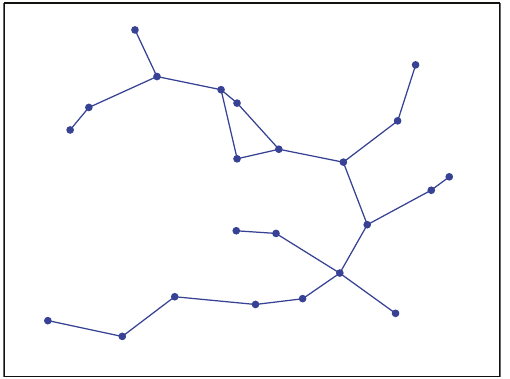
Figure 7: A sample random network with multiple multihop flows. These random networks are used to evaluate the flow oriented channel assignment (FOCA) algorithm.